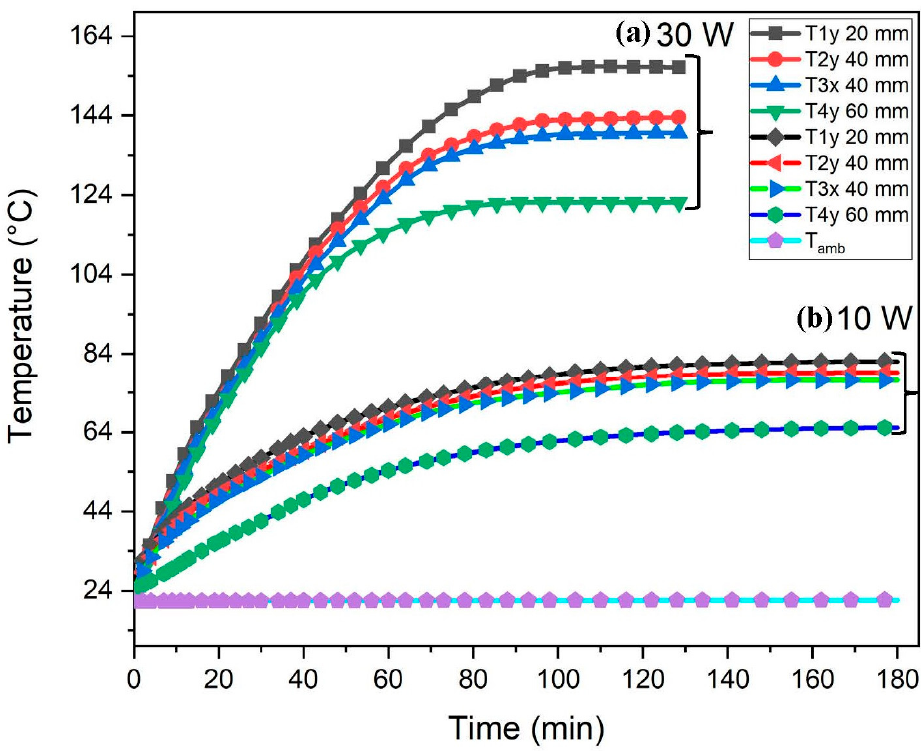
Figure 6. Temperature profile for enclosed cavity: ( a ) At input power of 10 W; ( b ) At input power of 30